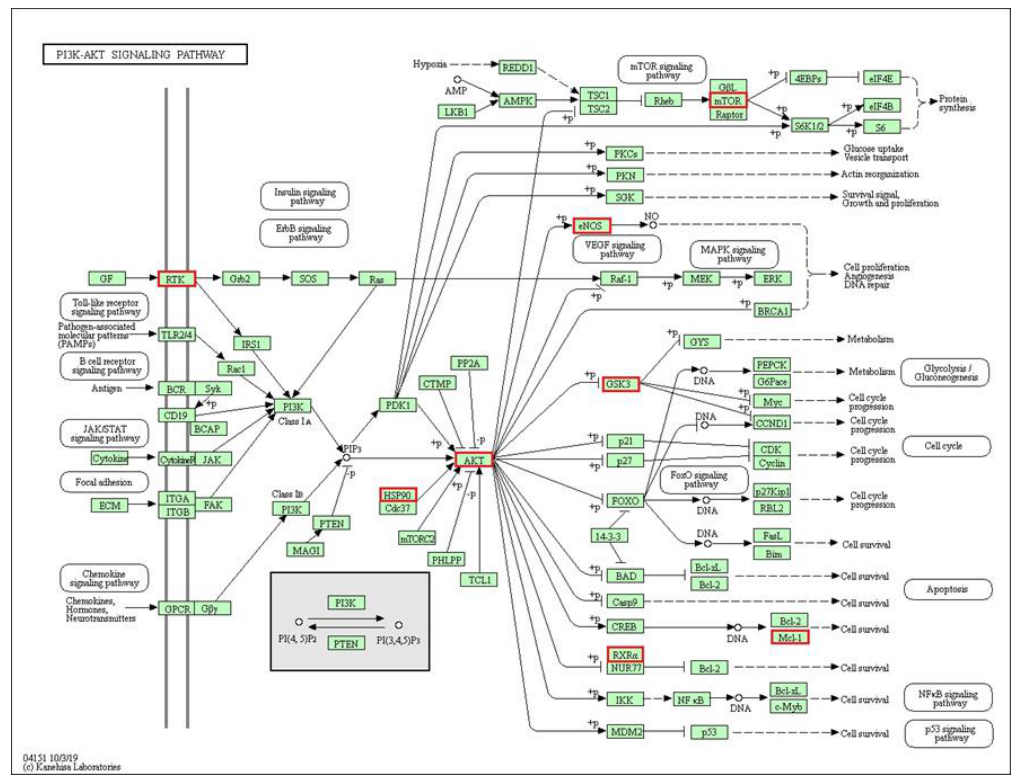
Figure 4. KEGG pathway for proteins associated to 5-oxocoronaridine in PI3K-AKT signaling pathway. Red squares represent potential targets of the molecule.